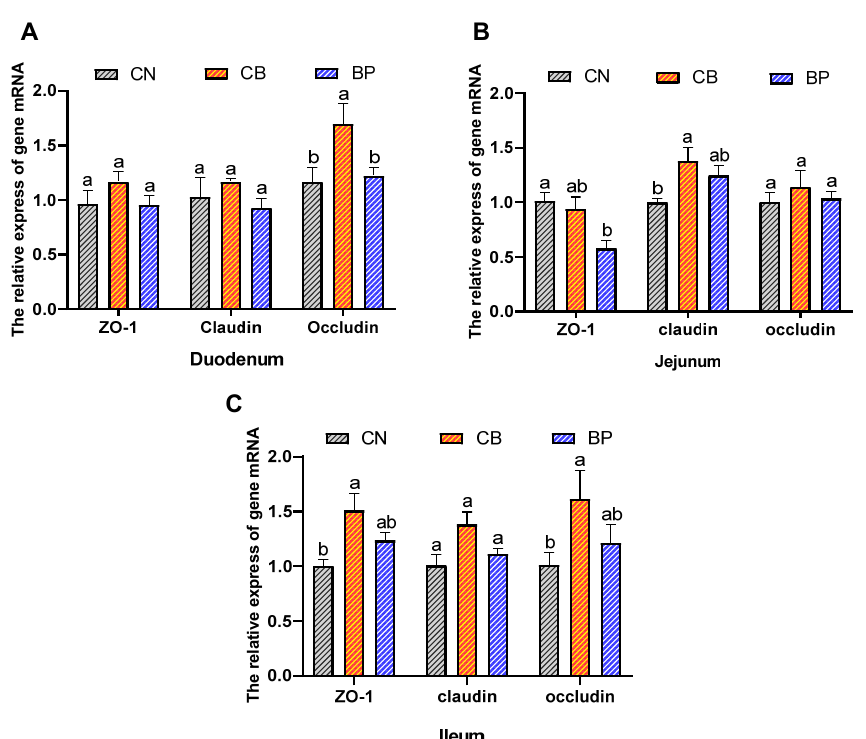
Figure 6. Effects of CB and BP on tight junction protein expression in rabbits. ( A – C ) The mRNA levels of tight junction proteins (ZO-1, occludin, claudin) in the duodenum, jejunum, and ileum, respectively. The mRNA level was quantified according to that of the housekeeping gene GAPDH, and the level of gene expression was expressed as the relative value compared to that of the CN group. CN, rabbits were fed a basal diet; CB, rabbits were fed a basal diet supplemented with Clostridium butyricum ; BP, rabbits were fed a basal diet supplemented with a bacteriophage cocktail (values are expressed as the mean ± SE, n = 8; a,b Mean values within a row with unlike superscript letters were significantly different ( p < 0.05).